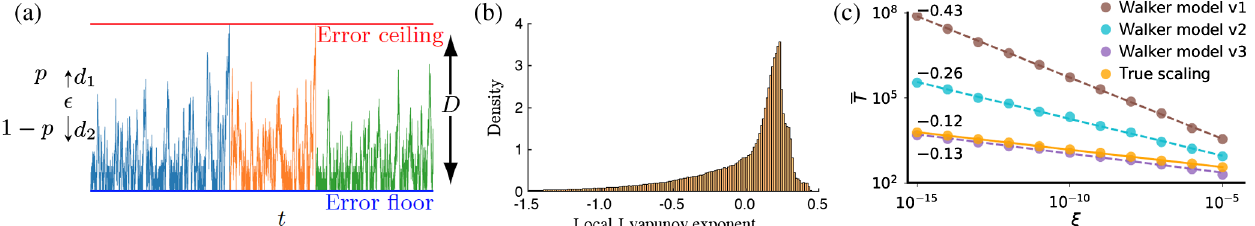
FIG. 3. Modeling transitions in switching chimeras. (a) Illustration of a random walk model in the log-error space, where a switching event is triggered when the walker reaches the error ceiling. The time series is colored differently after each switching event. (b) Distribution of the local Lyapunov exponents associated with Eq. (1) for σ ¼ 1 . 7 and r ¼ 3 . 05 , which is used to refine the random walk model for the switching chimeras. (c) Power-law scalings predicted by the random walk model and its refined versions (dashed lines). The scaling obtained from direct simulations of Eq. (1) is also shown for comparison (solid orange